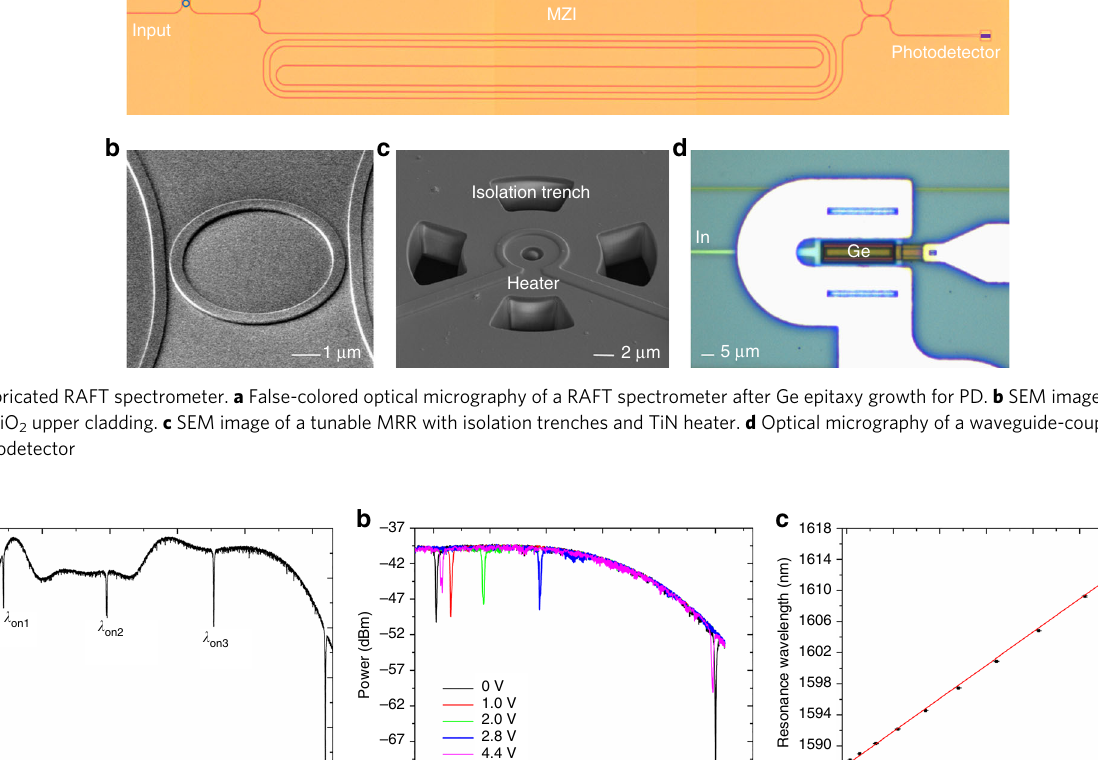
Fig. 17b. A tunable laser source (TLS-1: Santec TSL-510) is used for single wavelength characterization. Firstly, heating power is applied to heater 1 above the MRR to induce a resonance wavelength shift of Δ λ = 3.38 nm compared to the initial static state, thus the MRR has one resonance wavelength at 1584.620